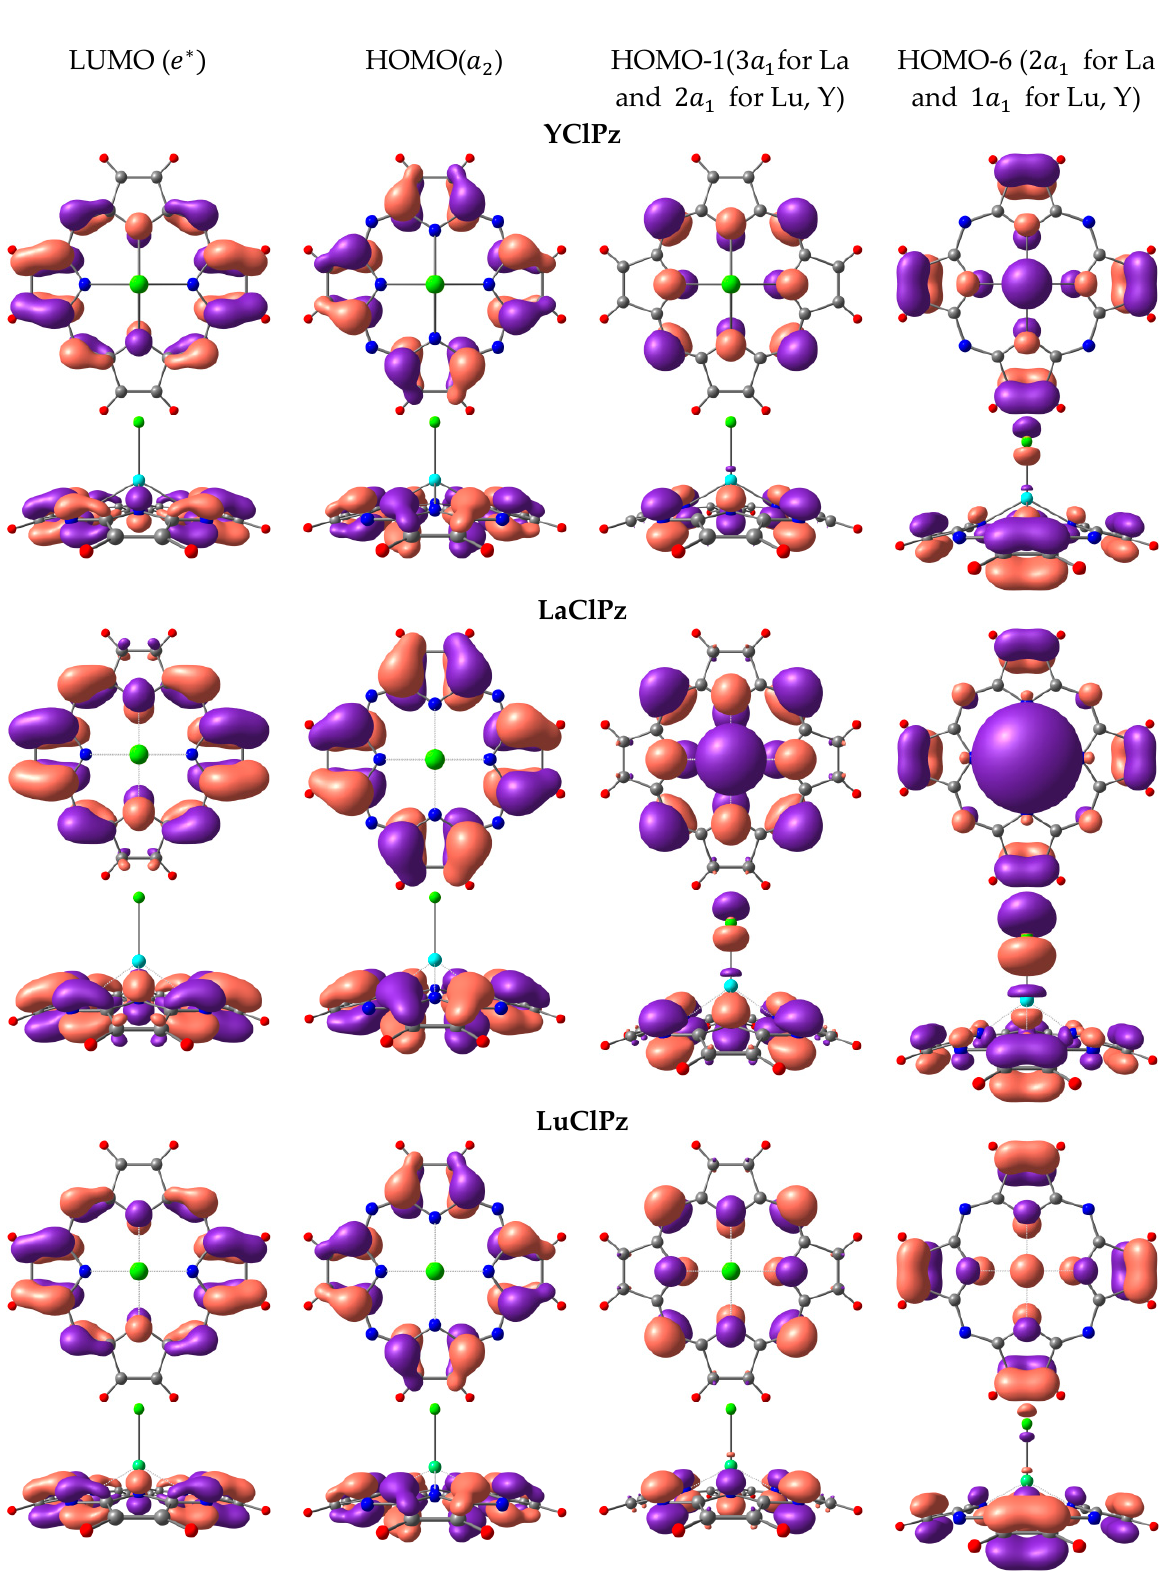
Figure 4. Influence of the metal (Y, La, Lu) on the molecular orbitals of MClPz complexes.